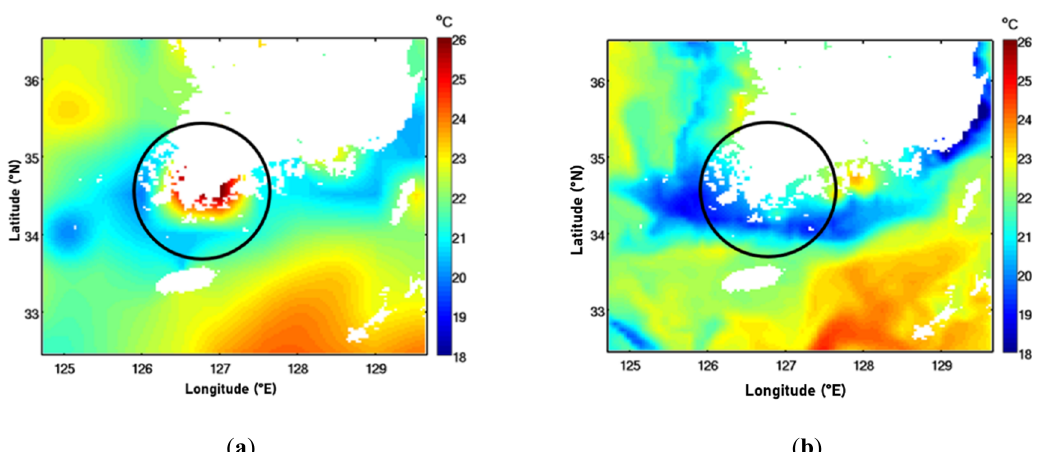
Figure 4. ( a ) Spatial distributions of real time global sea surface temperature (RTG SST) used in the original WRF model and ( b ) spatial distributions of hybrid coordinate ocean model sea surface temperature (HYCOM SST) used in the WRF-OML model at 00 UTC 1 July 2016.